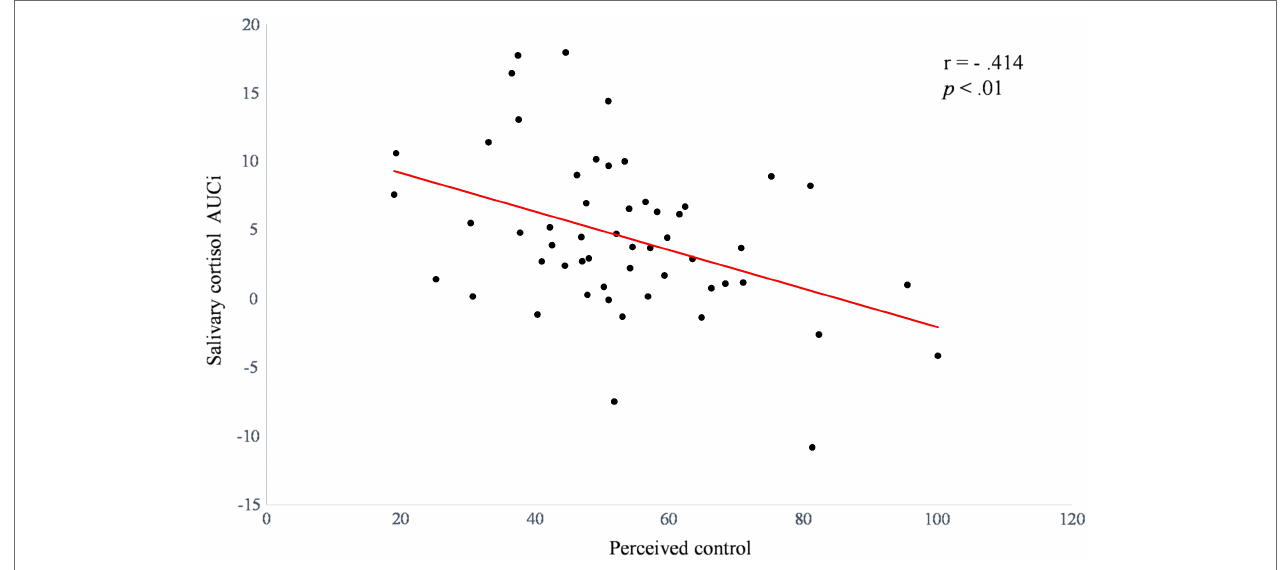
FIGURE 3 | Scatter plot of the bivariate correlation between perceived control and salivary cortisol AUCi to acute psychosocial stress ( n =